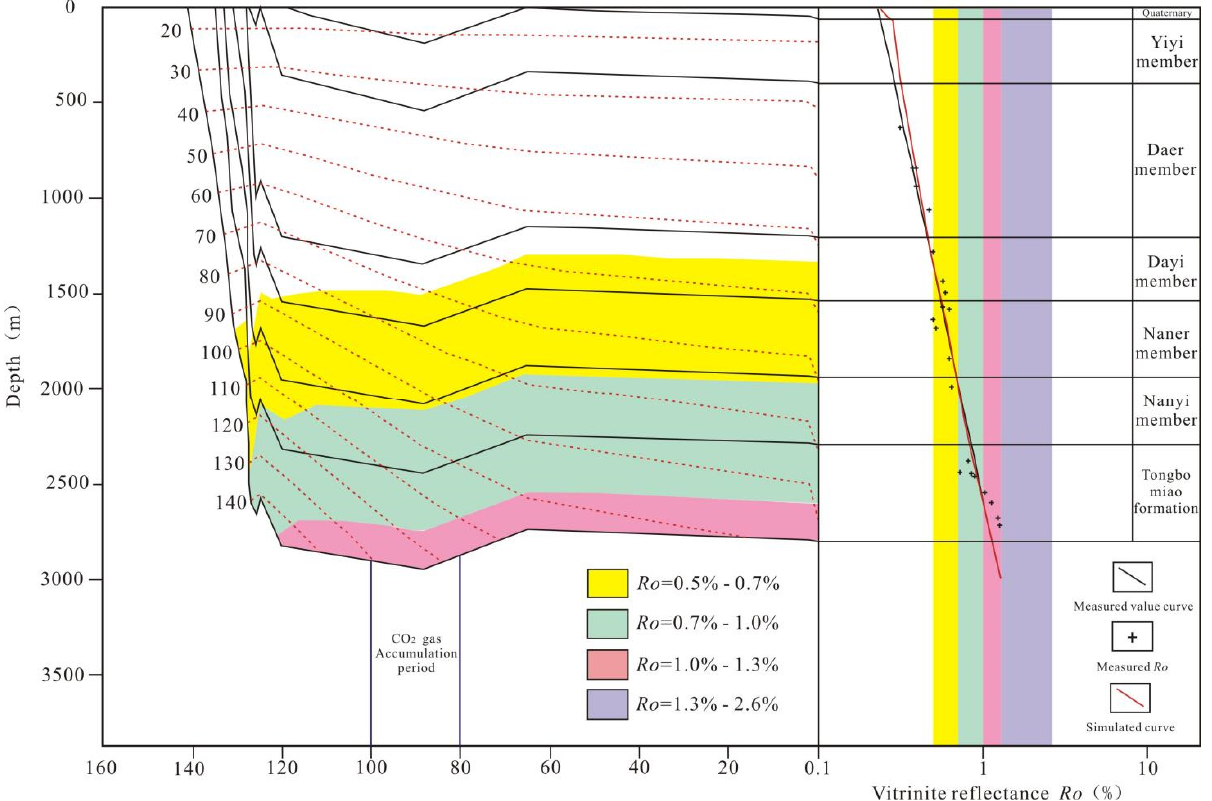
Figure 7. Thermal history of Haishen 4 in Wuerxun depression and accumulation period of CO 2 reservoir in Hailar Basin.